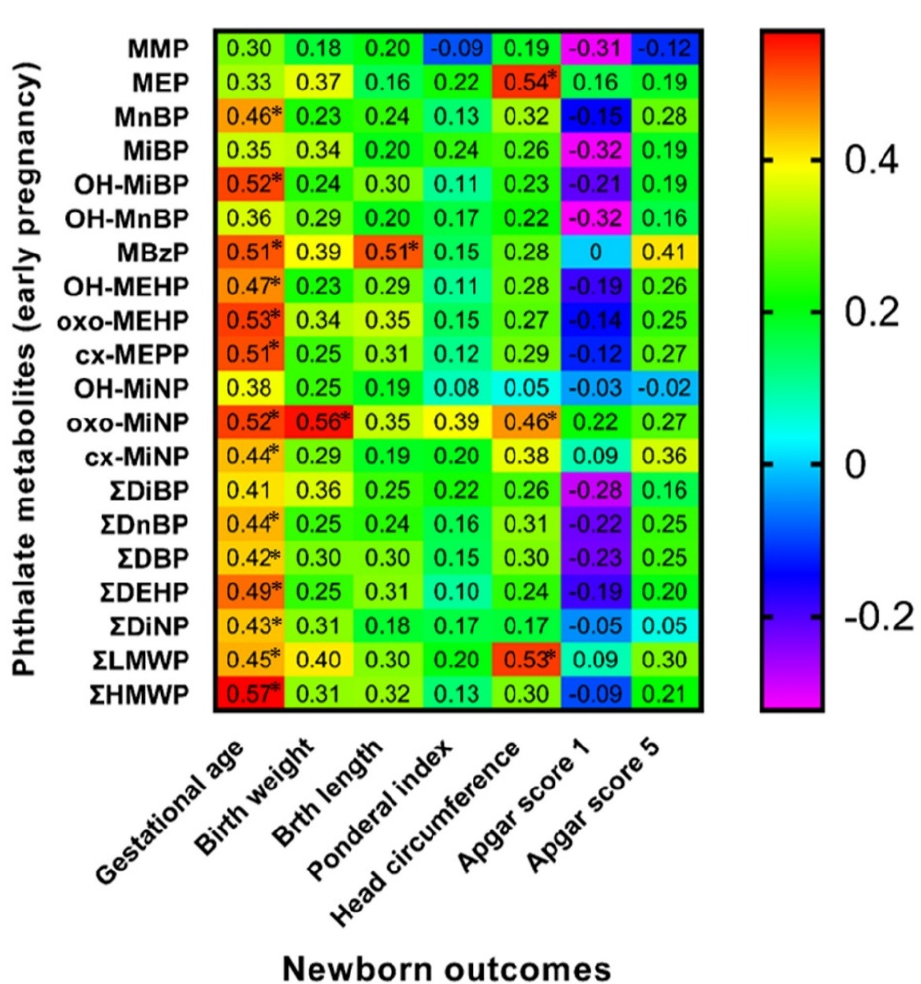
Figure 5. Correlation matrix of girl-newborn outcomes and maternal phthalate metabolites during early pregnancy ( ≤ 15. w.g.). Legend is shown in the footnote of Table 4. * The correlation is significant at the level p ≤ 0.05.